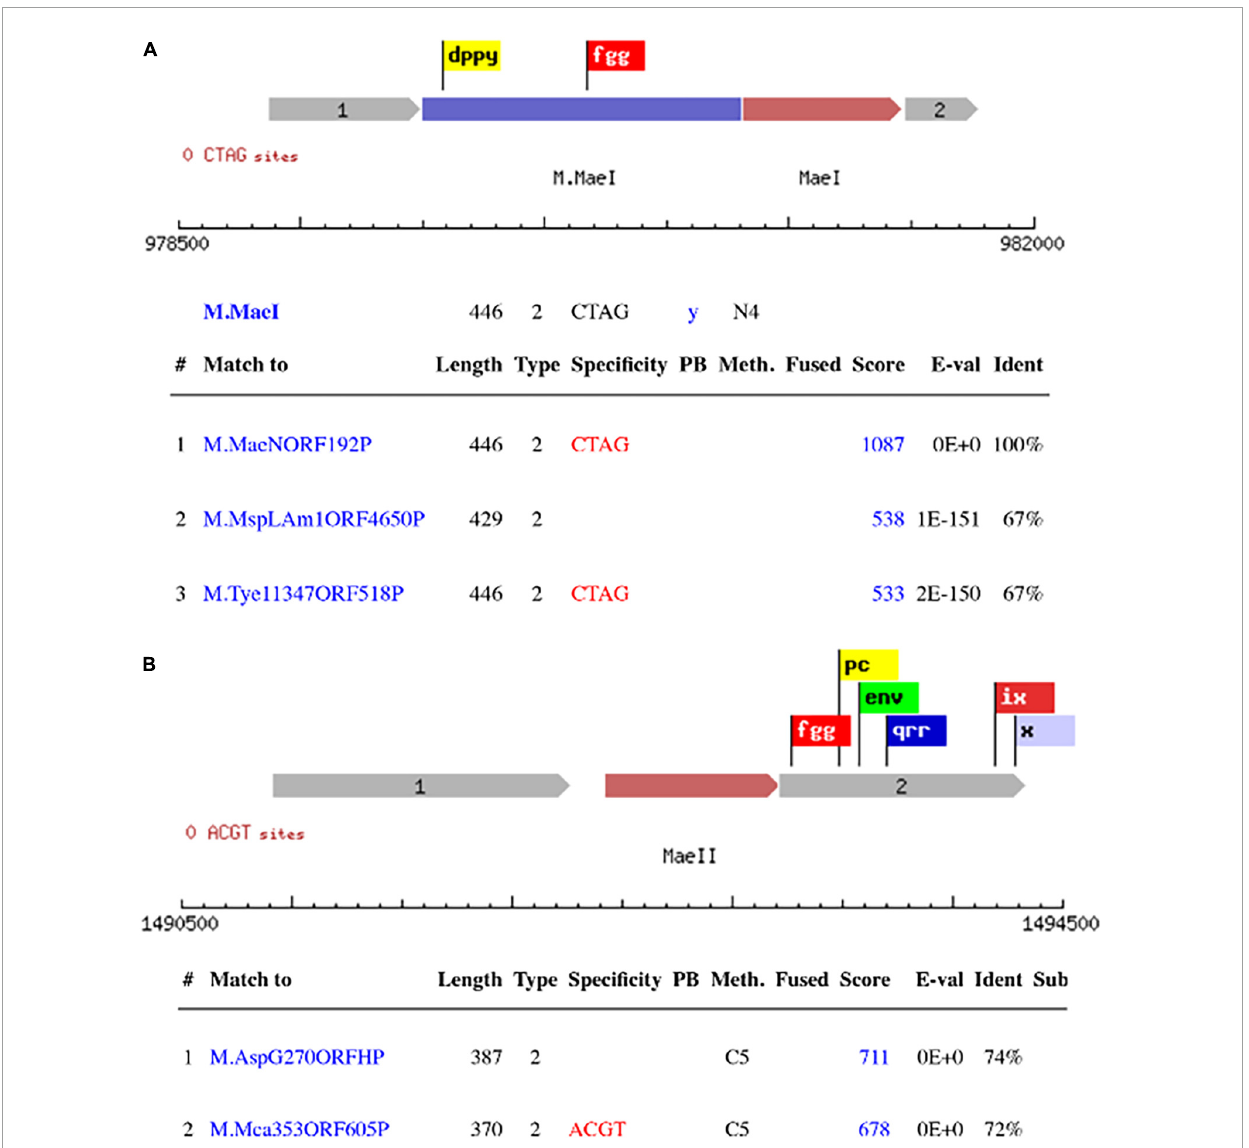
FIGURE2 Schematic presentation of RM systems assigned bioinformatically based on homology search against DNA methylase genes with known specificity in REBASE. M. Mae I with the top 3 blast hits (A) , M. Mae II with the 2 top blast hits (B) . The flags represent the conserved motifs that are used to identify the methyltransferase